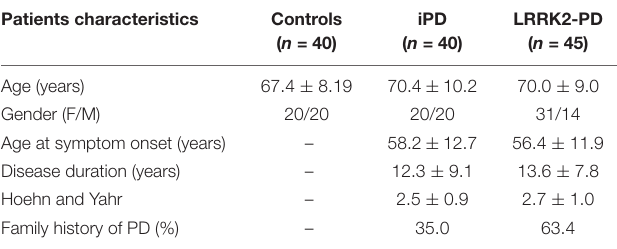
TABLE 1 | Clinical features of patients and